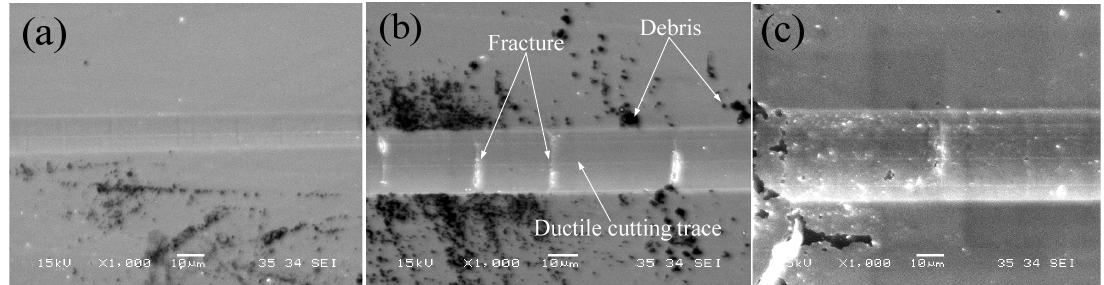
Figure 8. SEM photograph of cutting groove topography for BK7 at 300 mm/min: